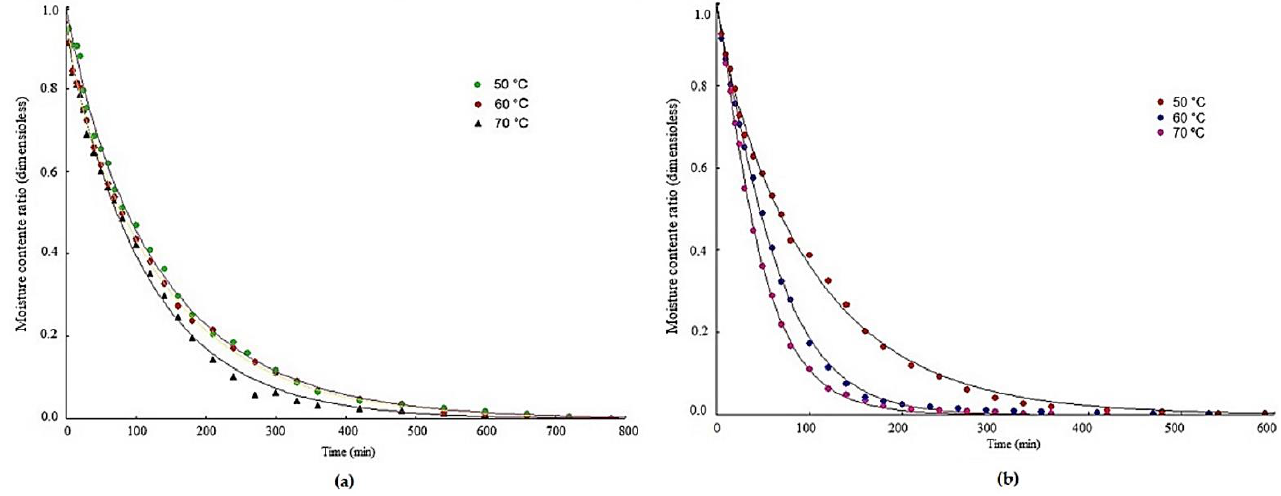
Figure 1. Pomegranate drying kinetics at temperatures of 50, 60 and 70 °C: ( a ) peels and ( b ) seeds. Drying curves similar to those of pomegranate seeds were verified by Santos et al. [42] determining the pomegranate drying kinetics (seed and pulp) at temperatures of 50, 60, and 70 °C, where they reported that the drying curves were influenced by temperature, with a gradual reduction in drying times observed as the drying air temperature was in- creased; by Moscon et al. [53] analyzing the drying kinetics of quinoa ( Chenopodium quinoa W.) grains at temperatures of 40, 50, 60, and 70 °C, who also noticed an inverse behavior between temperature and time required for drying, that is, a reduction in drying time and an increase in water removal with increasing temperature; and by Santos et al. [42] who determined the modeling and the pomegranate peel drying kinetics, also verifying the decrease in drying time with increasing temperature. The highest drying rate was ob- tained at the highest temperature (80 °C) and the time spent to dry the peels at the lowest temperature (50 °C) was almost triple the time required to dry them at the highest tem- perature. Mphahlele et al. [41] reported in their study of drying kinetics of pomegranate peel (cv. Wonderful) at three temperatures (40, 50, and 60 °C) that the drying rate was higher at the beginning of the process, possibly due to evaporation of the peel surface water, which subsequently decreased with decreasing water content for the entire tem- perature range, and the drying process occurred mainly in the period at the decreasing rate for the entire temperature range, indicating that the mass transfer occurred by diffu- sion. 3.2. Effective Diffusivity Table 5 shows the values of effective diffusivities determined from the drying kinet- ics of pomegranate seeds and peels. Diffusivity is used to indicate the flow of water within a material and is primarily influenced by the material’s water content and temperature.